Question: In a single sentence, describe what this figure presents.
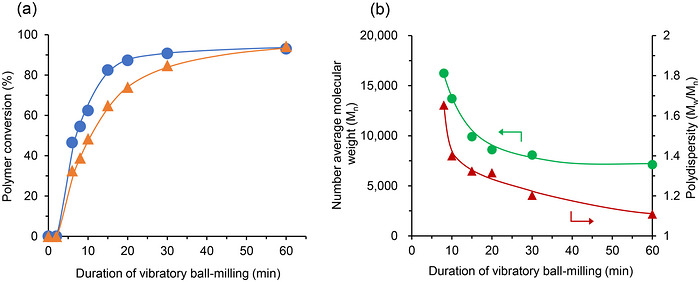
Answer: Progressive changes in the polymer conversion rate of SBMA (circle) and ART‐ethyl‐MA (triangle) during solid‐state copolymerization (a), and molecular weight (circle) and polydispersity (triangle) of resulting polymers synthesized by the copolymerization (b).